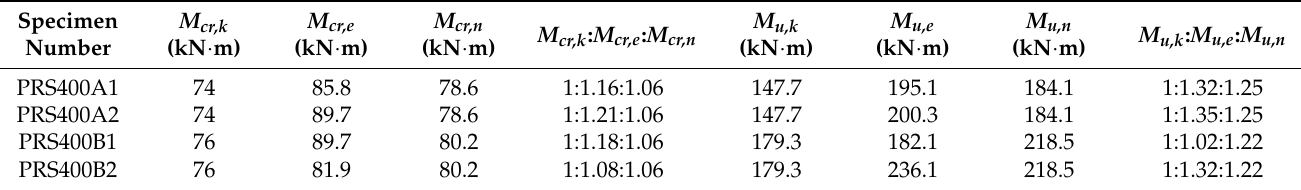
Table 5. Comparison of numerical simulation results, test results, and formula calculations of flexural properties of specimens.